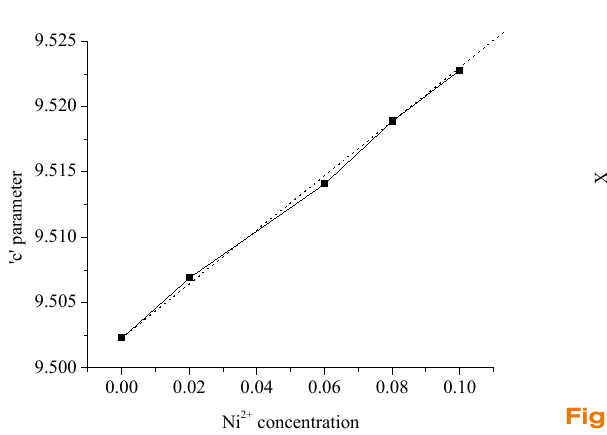
Figure 3. Kubelka Munk plot for various photocatalysts mentioned. X = (1-R ) 2 / 2R , R is ratio of the relative reflectance ∞ ∞ ∞ to reflectance of non absorbing medium; (1-R ) 2 is the ∞ molar absorption co-efficient and 2R is the scattering ∞ coefficient.